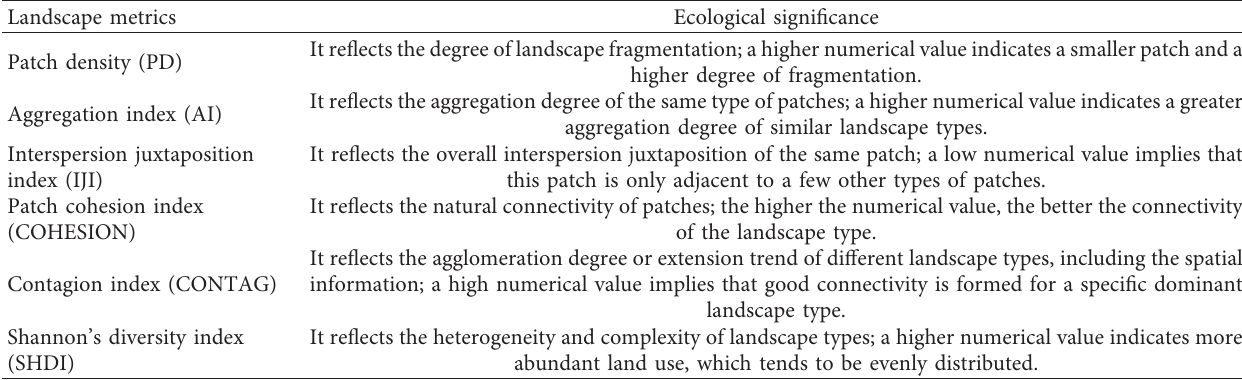
Table 4: Interpretation table for landscape metrics.